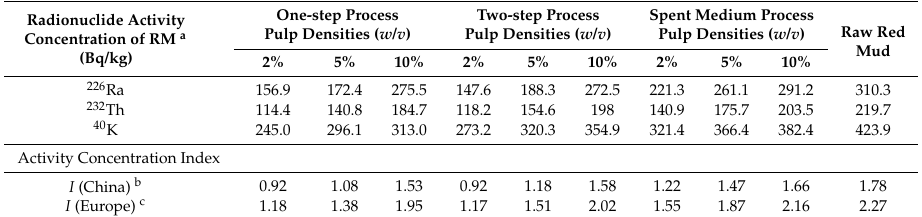
Table 2. Radionuclide activity concentration of bioleached RM residue after treatment by one-step, two-step and spent medium processes.